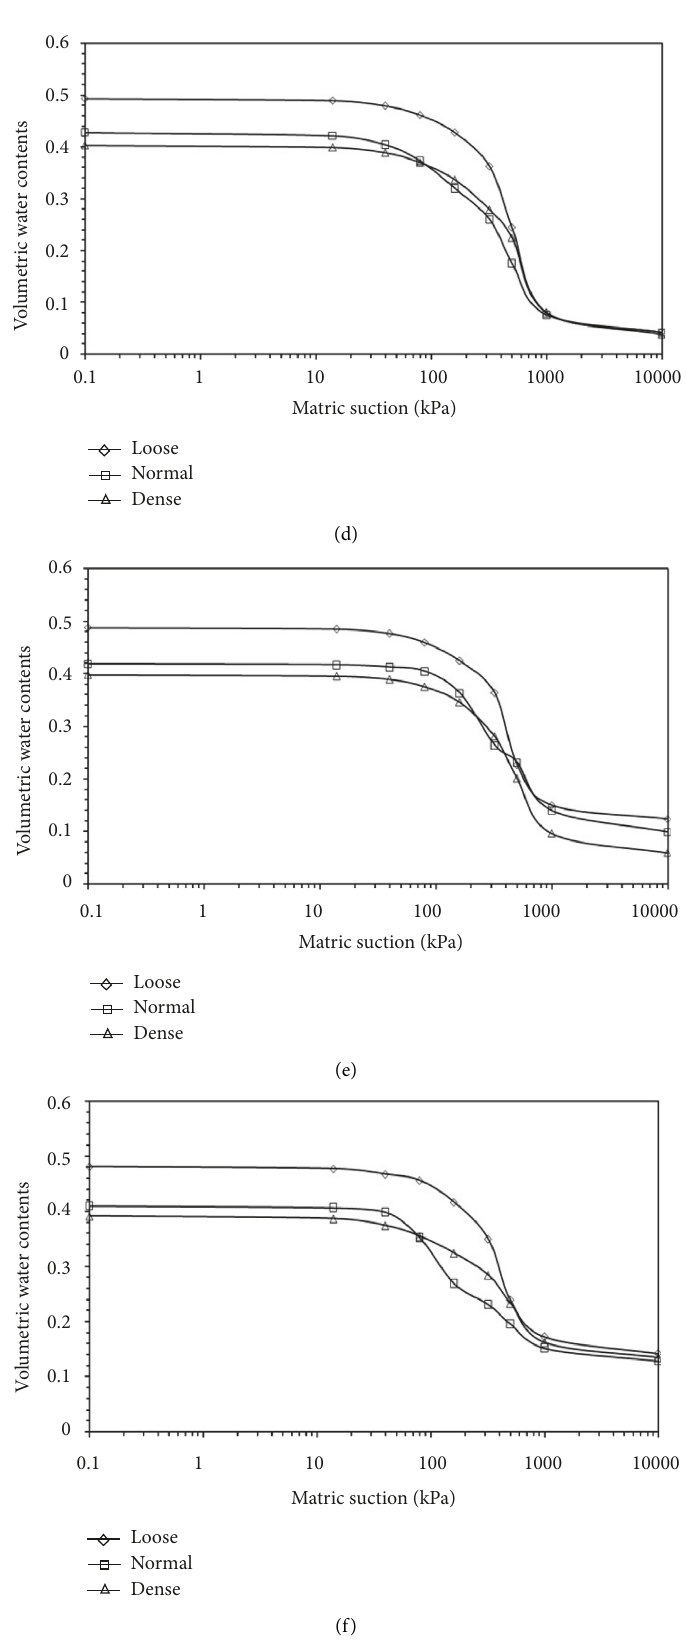
Figure 11: Sample SWRCs based on compaction condition: (a) CS-1, (b) CS-2, (c) CS-3, (d) CS-4, (e) CS-6, and (f)